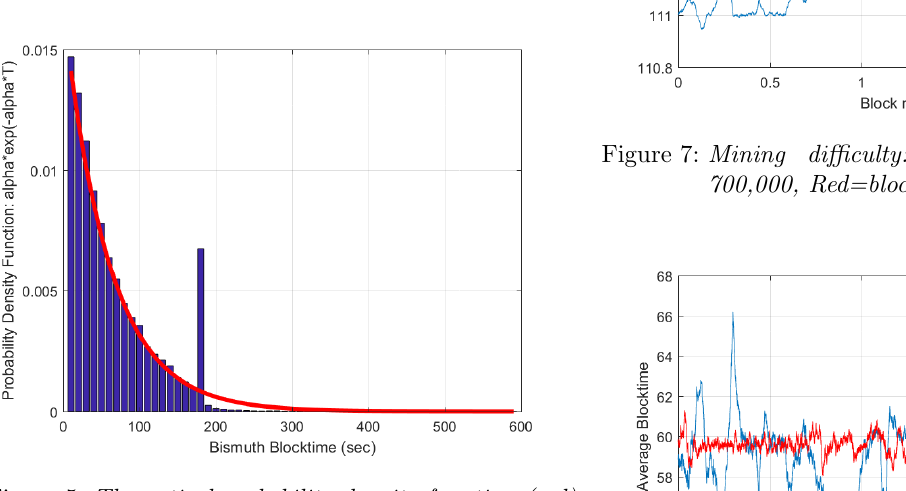
Figure 5: Theoretical probability density function (red) for the bismuth blocktime compared against data in blocks 701,441-726,440 (blue) which have tail removal activated.